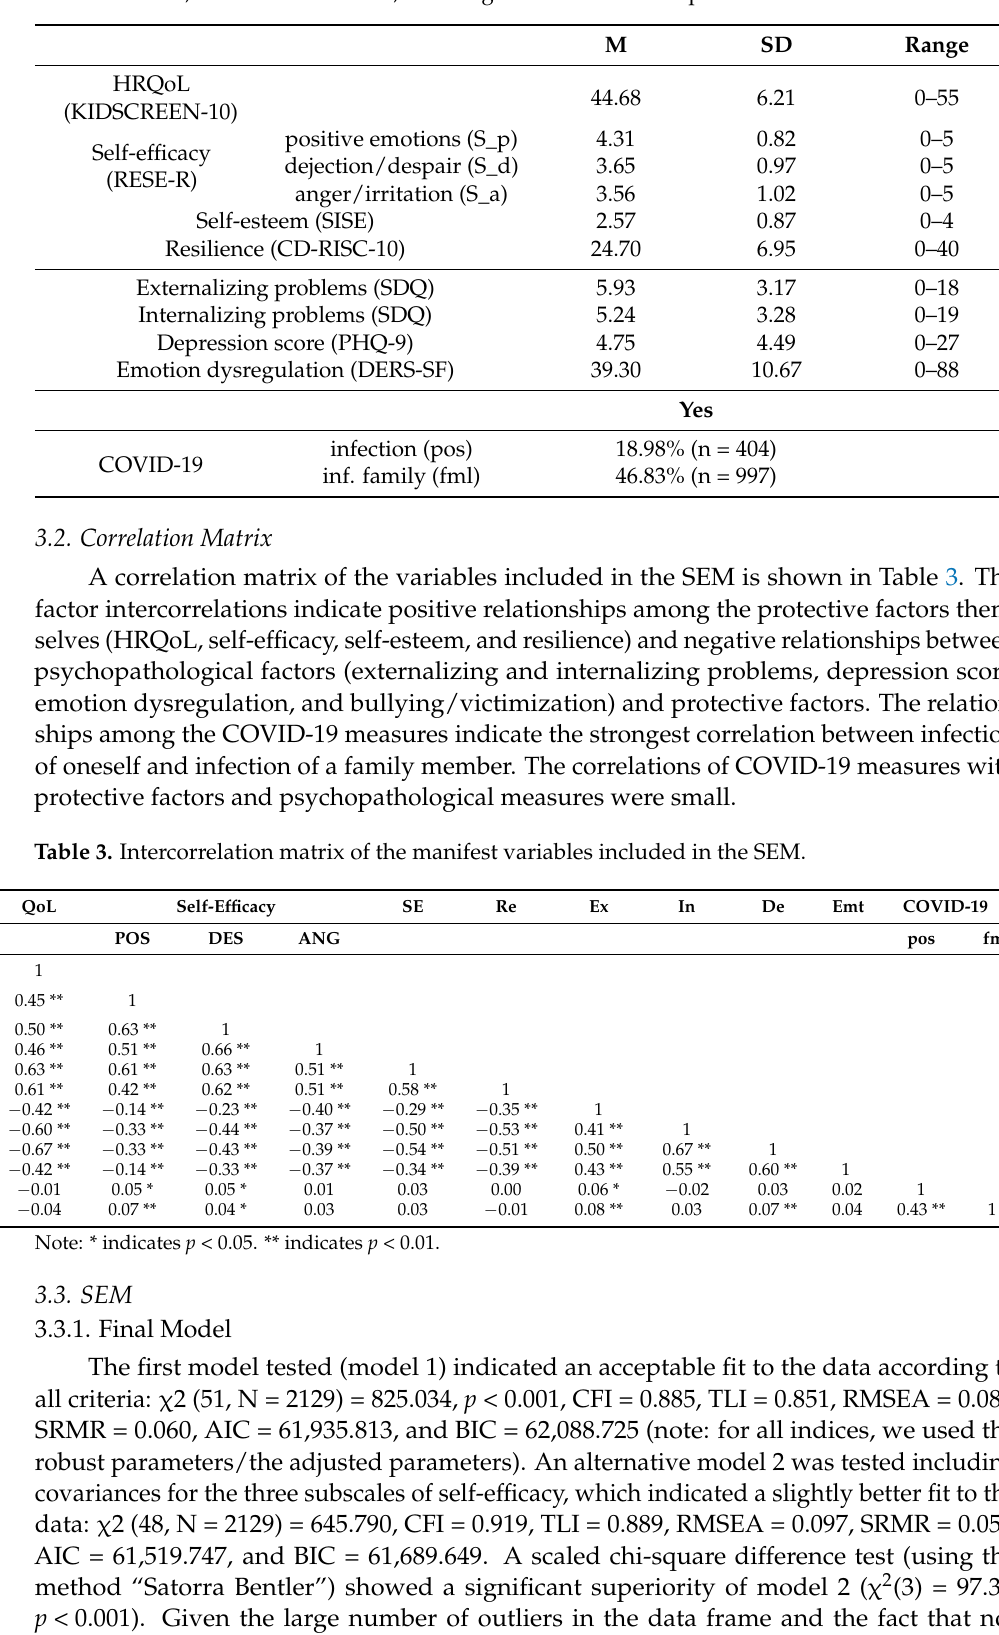
Table 2. Means, standard deviations, and range for the whole sample.